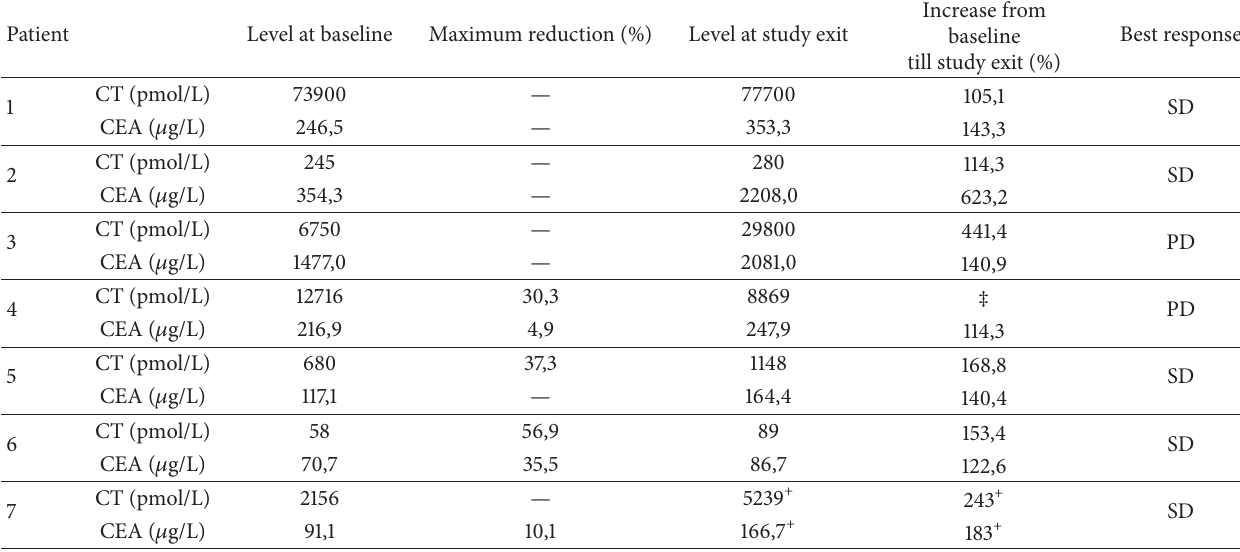
Table 3: Changes in calcitonin and CEA during treatment.